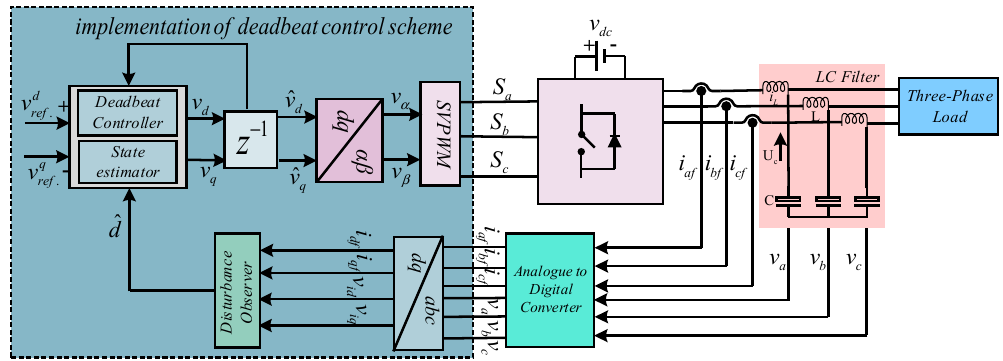
Figure 32. Deadbeat control topology for VSIs.